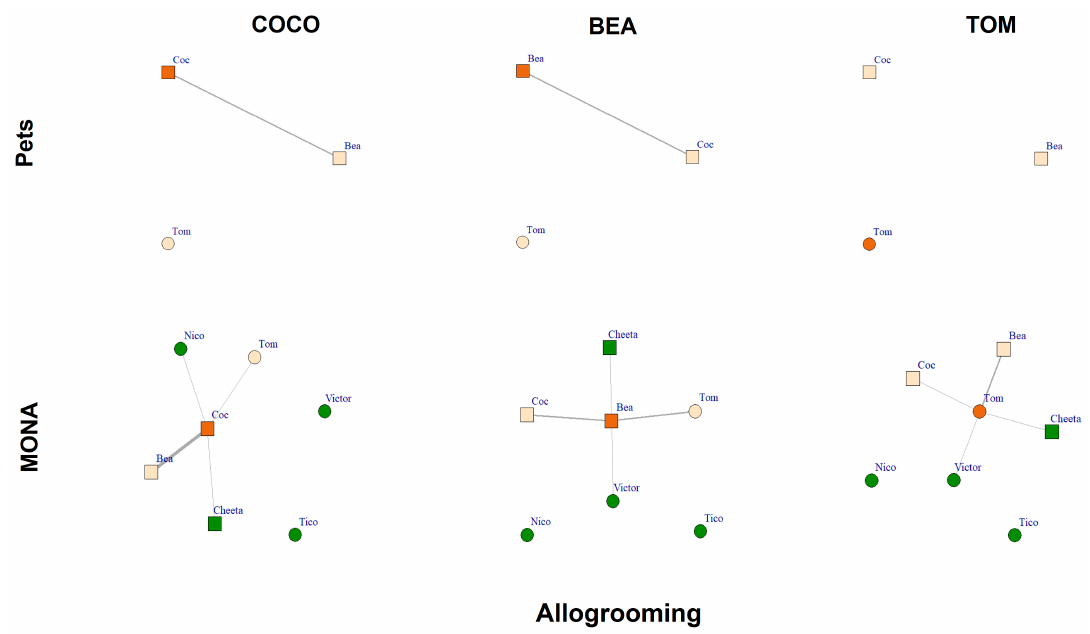
Figure 6. Allogrooming networks of Coco, Bea and Tom while housed as pets (upper row) and at MONA (bottom row). Edges represent percent of scans spent engaged in allogrooming (given and received); circles represent males; squares represent females. Vertex colour: orange = focal individual; peach coloured = familiar individuals; green = new conspecifics at MONA.